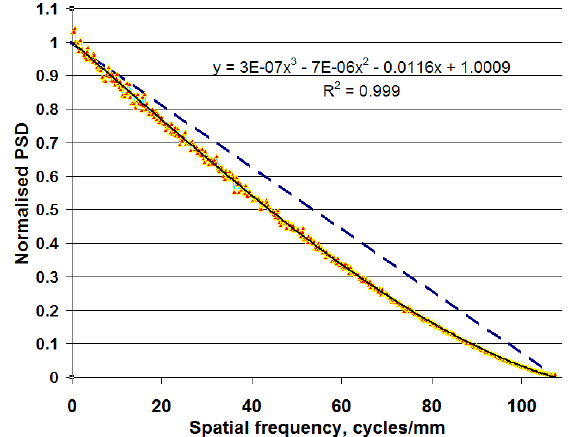
Fig. 3. Normalized PSDs: blue dashed line depicts theoreti- cally calculated input PSD (using Eq. (6)), the scattered data is experimentally obtained at 535 nm wavelength, and black solid curve depicts the third order fit to the experimental data.